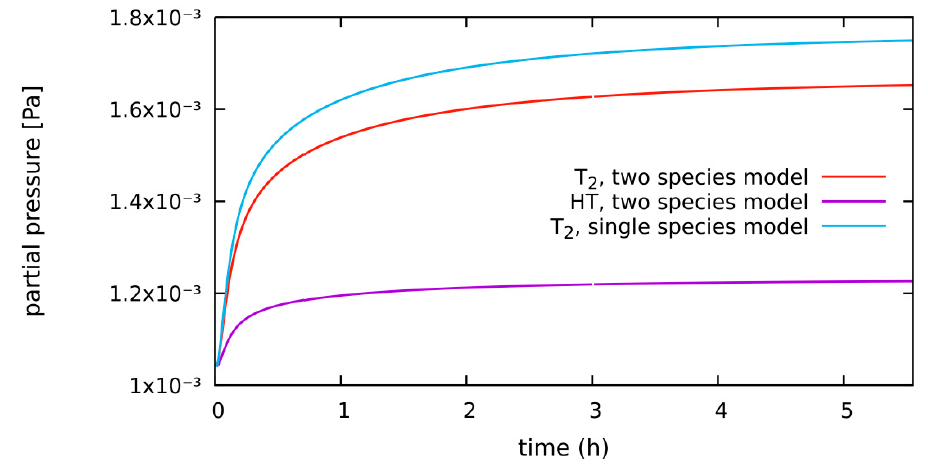
Figure 5. Transient T 2 and HT partial pressure at coolant outlet for single- vs. two-species model with no/1 × 10 − 3 Pa H 2 in the purge gas.